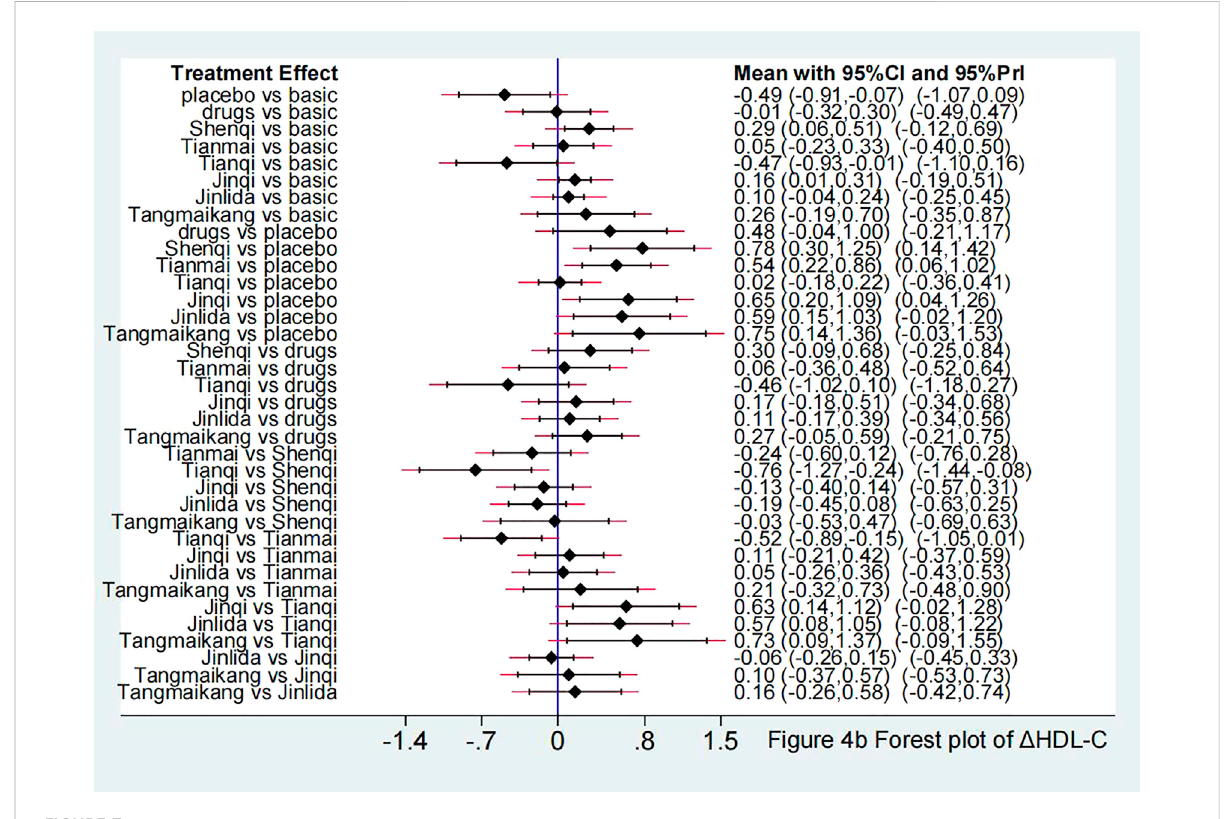
FIGURE 7 Forest plot in Δ